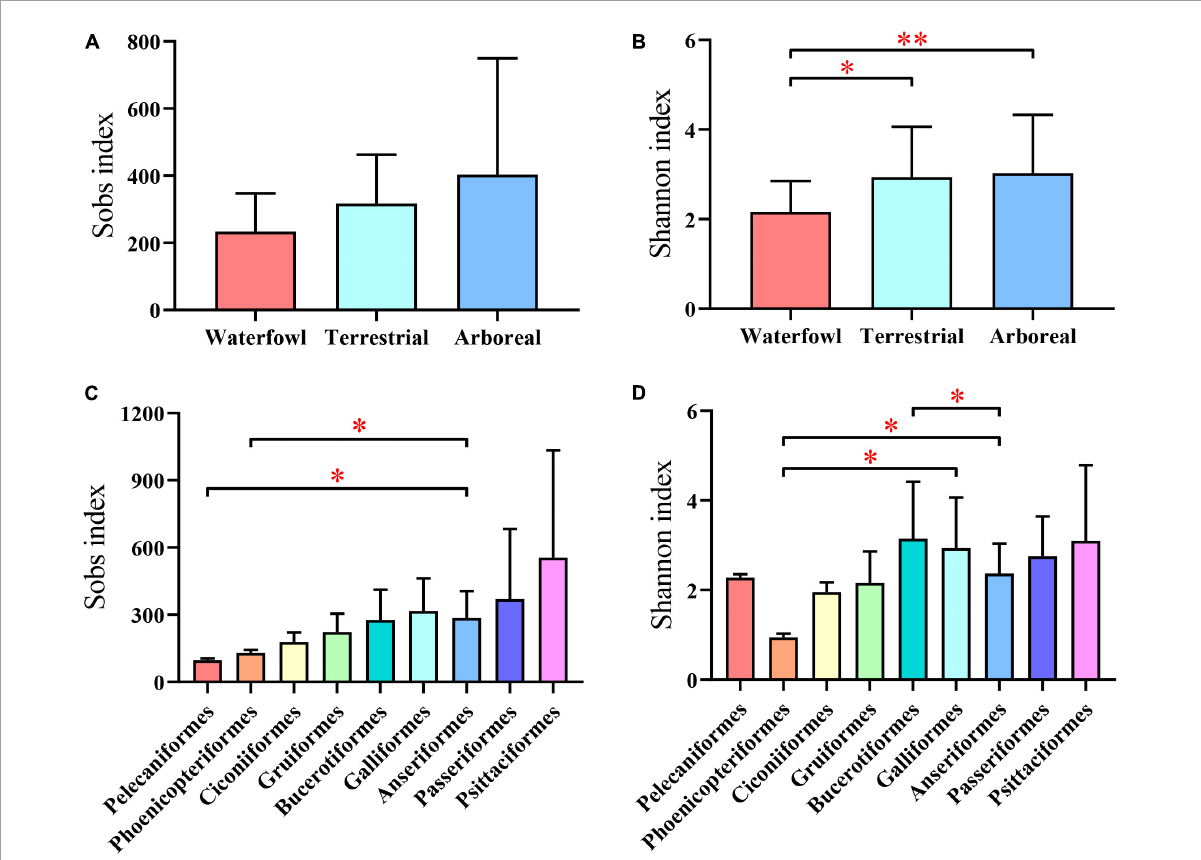
FIGURE3 The observed species index (Sobs index) and Shannon index at the OTU level of intestinal communities for (A,B) different ecological types and (C,D) different orders. Student’s t -test was used to test the significance. (*0.01 < P < 0.05, **0.001 < P <